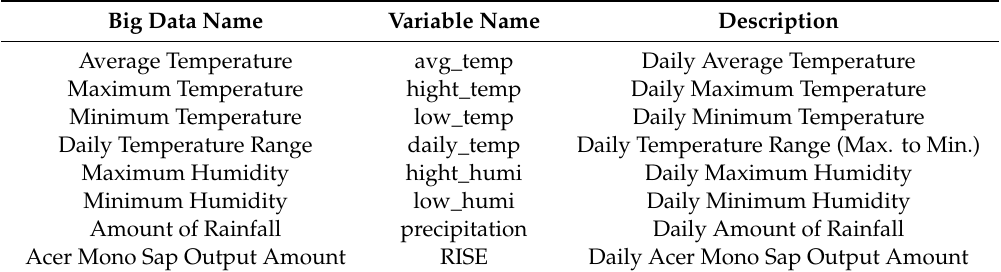
Table 1. Element of data set.